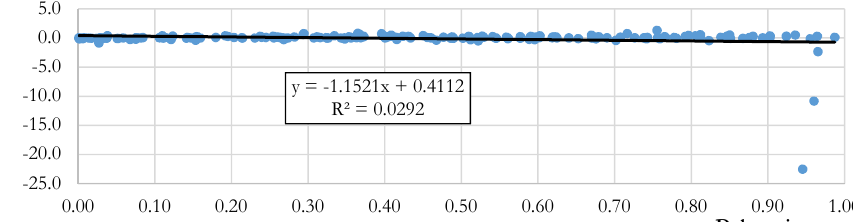
Fig. 8 – Relationship of ROE and debt ratio in the business sector N - Administrative and support service activi- ties. Source: Own